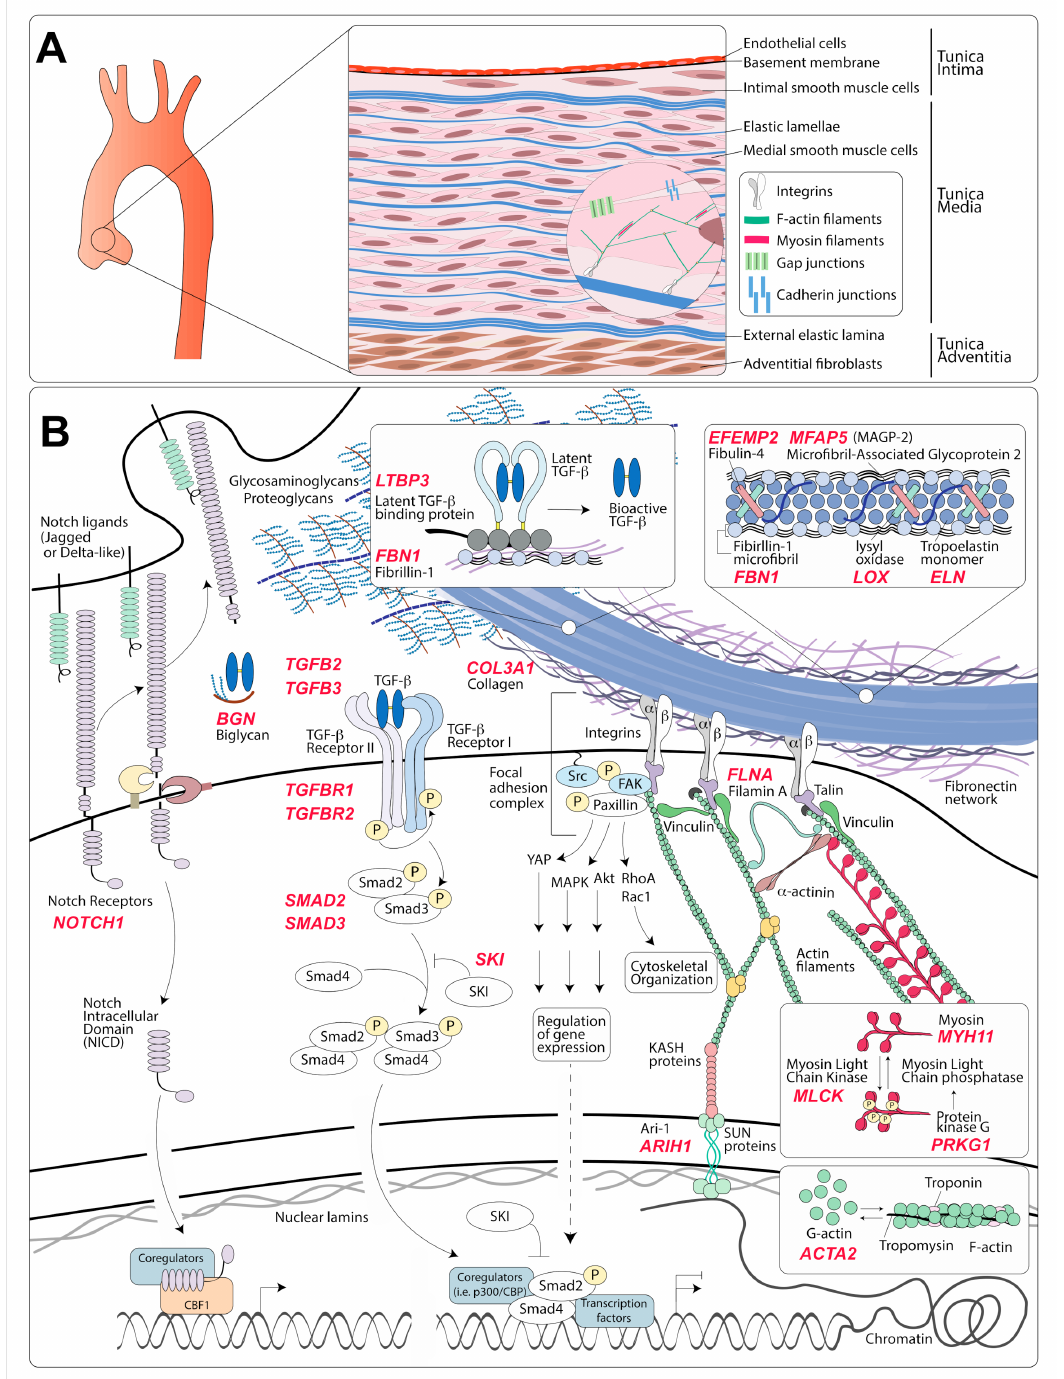
Figure 1. Organization of the aortic wall and representation of molecular pathways affected in hereditary aneurysm disorders. ( A ) Schematic representation of the thoracic aorta magnified to illustrate the composition of the three aortic layers, cell types, and intracellular features of vascular smooth muscle cells (VSMCs). The aortic media is composed of alternating layers of VSMCs and elastic lamellae. Integrins link the actin cytoskeleton to elastic fibers and other extracellular matrix components (ECM). Cadherin and gap junctions allow sharing of mechanical and biochemical information between adjacent cells. ( B ) Representation of molecular components involved in the transmission of mechanical and biochemical information in the vascular wall. Causal mutations for hereditary thoracic aortic aneurysm (TAA) have been found in proteins coded by genes noted in red. Elastic fibers are composed of a core of elastin surrounded by microfibrils; although fibrillin-1 is the main component of microfibrils, they also include other glycoproteins such as microfibril-associated glycoproteins and